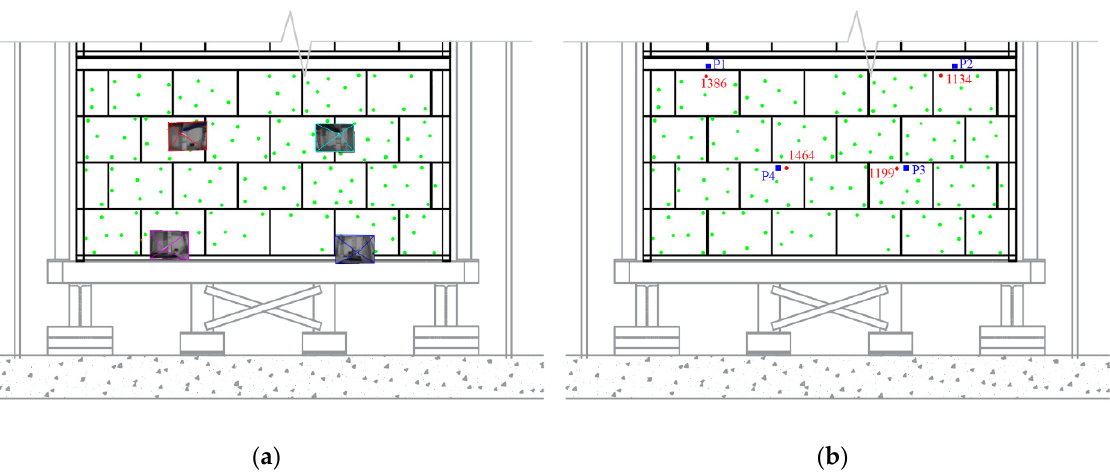
Figure 5. Photogrammetric network: ( a ) camera network used during the test, and ( b ) spatial distribution of monitored targets: the monitored targets (in green) and the nearest targets (in red) (1386, 1134, 1199, 1464) to the potentiometers P1, P2, P3, and P4, respectively, used to monitor out-of-plane displacements. The location of sensors P1 to P4 was chosen as a consequence of the possibility to connect these sensors to the external timber reference frame at those locations. P3 and P4 were wire potentiometers, and the other were two linear